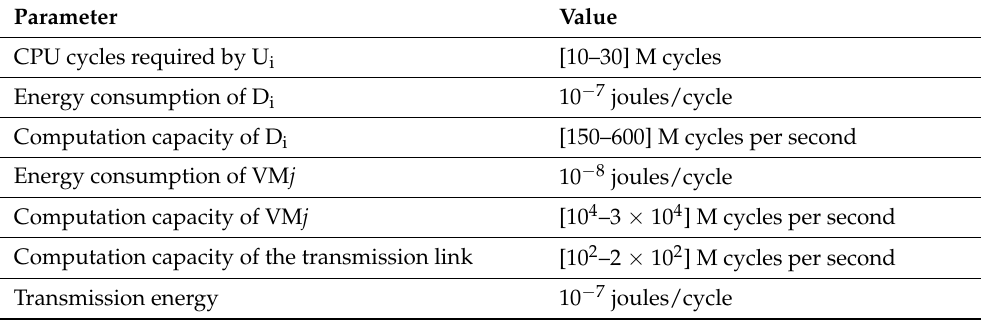
Table 2. Simulation